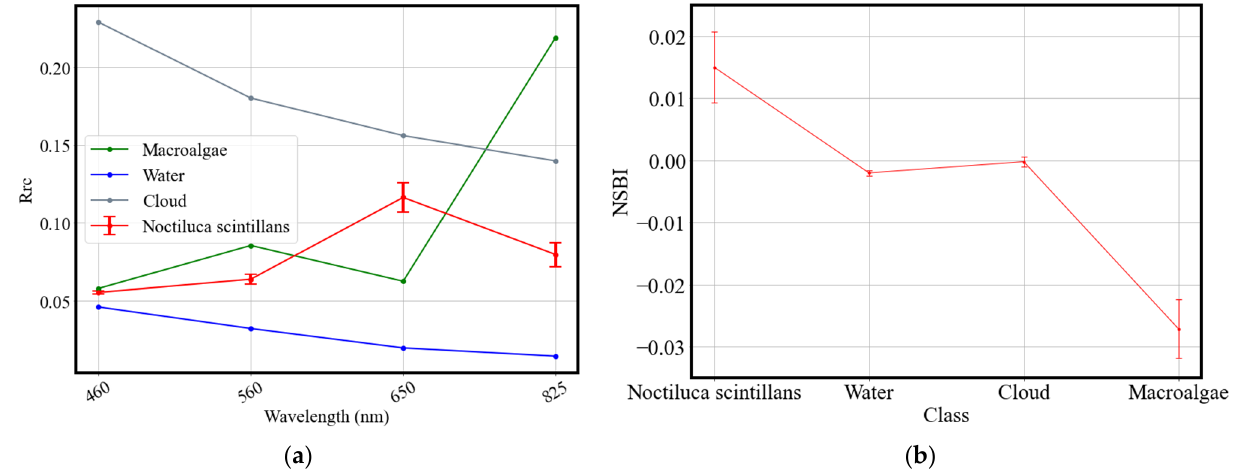
Figure 4. ( a ) Spectral reflectance and ( b ) the corresponding NSBI values of four typical targets on the sea surface.